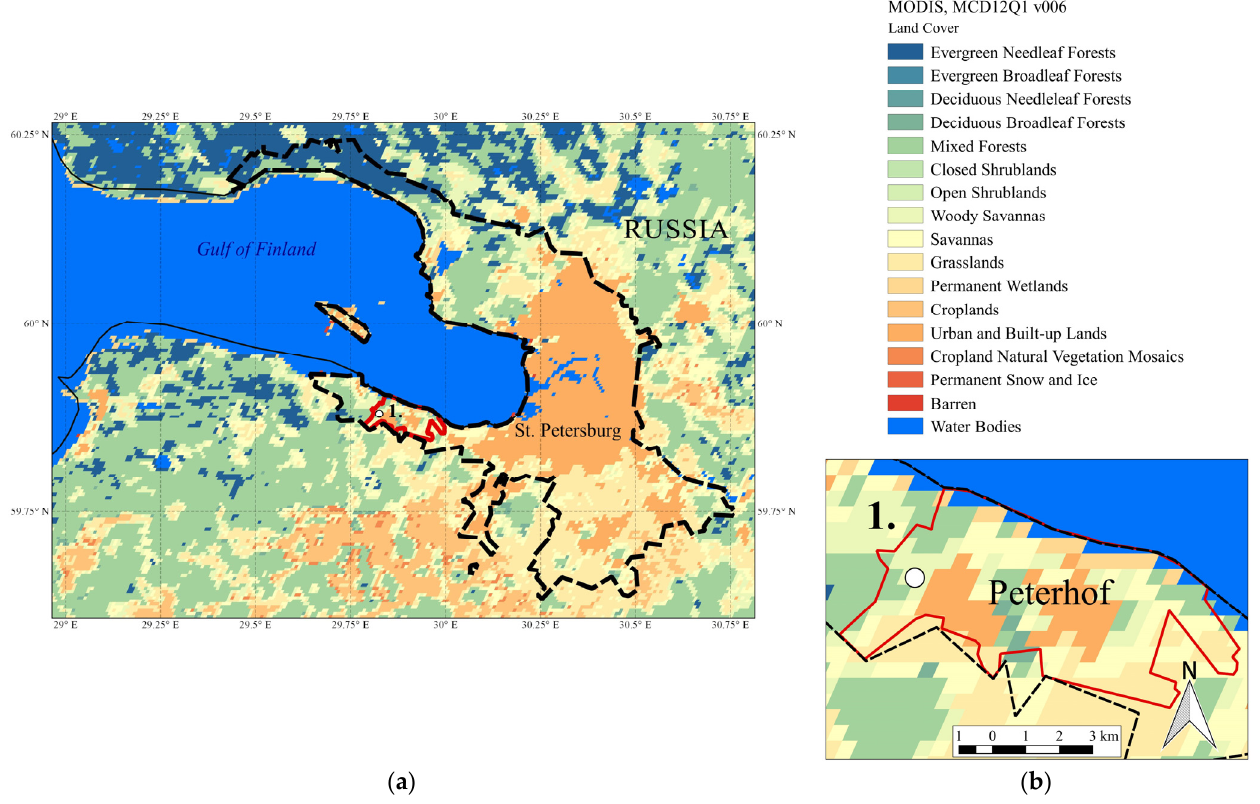
Figure 1. Land types according to the Annual International Geosphere–Biosphere Programme (IGBP) classification derived from MODIS (MCD12Q1 v006) for the territory of Saint Petersburg ( a ) and Peterhof ( b ) (Russia); the white circle depicts the position of the Peterhof measurement